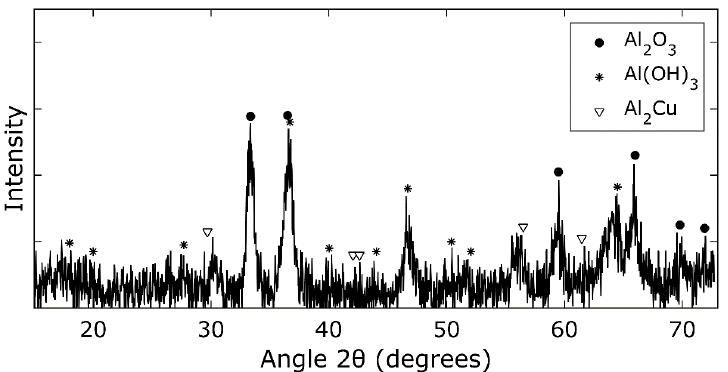
Figure 16. XRD diffraction pattern for EC sample corroded, without stirring during corrosion and aerated after that. Take from the same sample viewed in Figure 13.